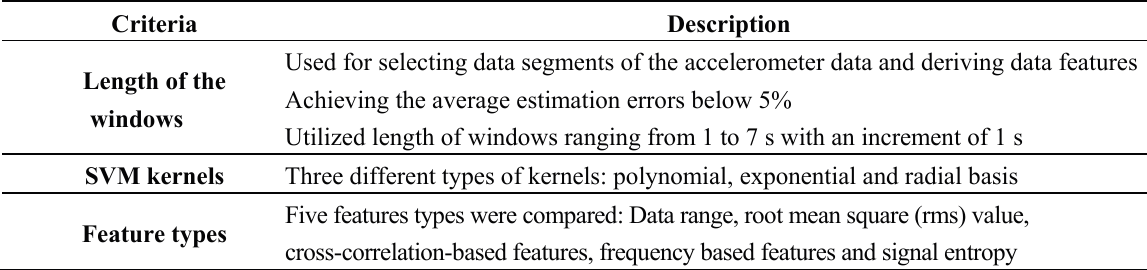
Table 4. List of criteria considered in estimating symptom severity of PD